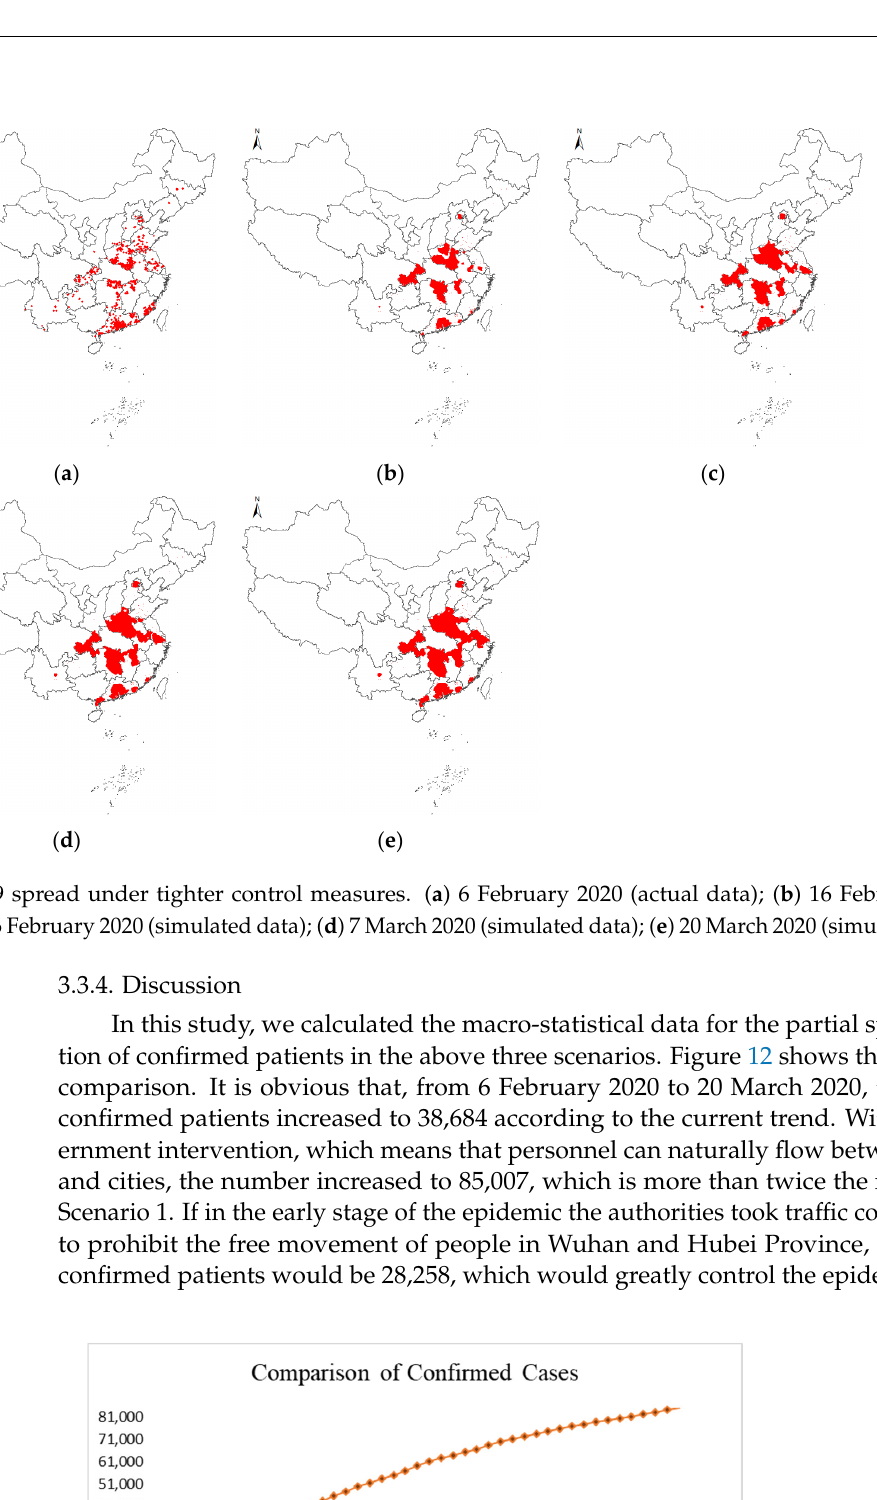
Figure 10. COVID-19 spread under no government control. ( a ) 6 February 2020 (actual data); ( b ) 16 February 2020 (sim-